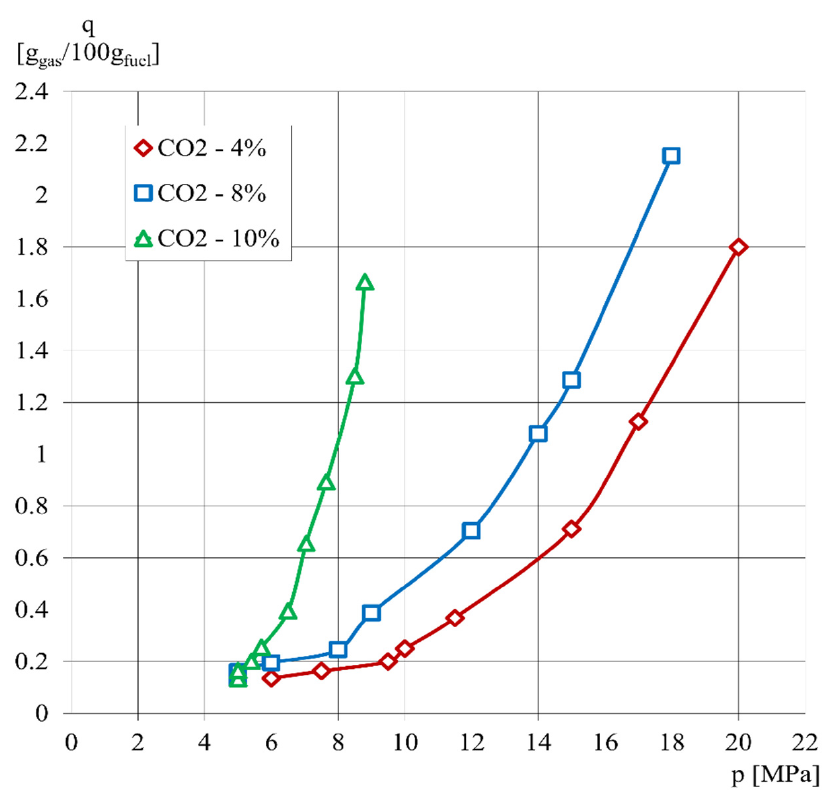
Figure 6. Results of the measurements of the coefficient of solubility of exhaust gas in diesel fuel under ambient conditions for (t amb = 22 °C, p amb = 1012 hPa).